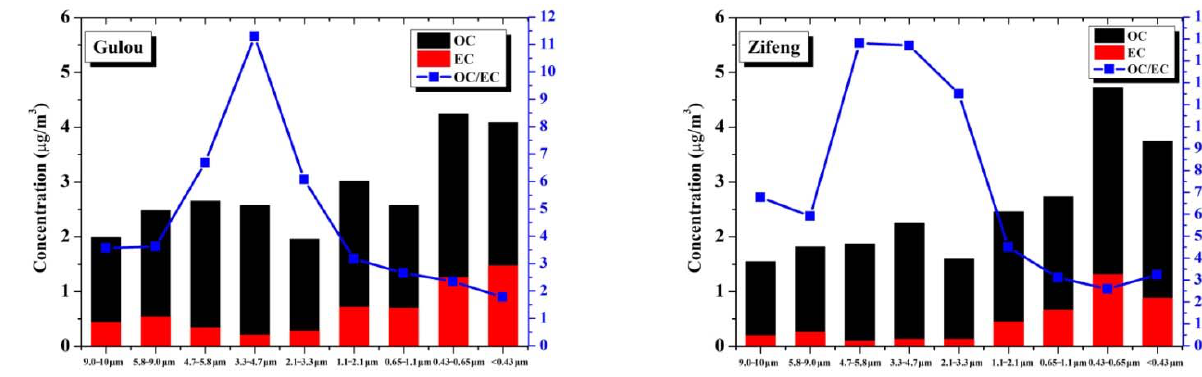
Figure 6. Carbonaceous species and ratios of OC/EC of size-fractionated PM at Gulou (20 m) and Zifeng (380 m).